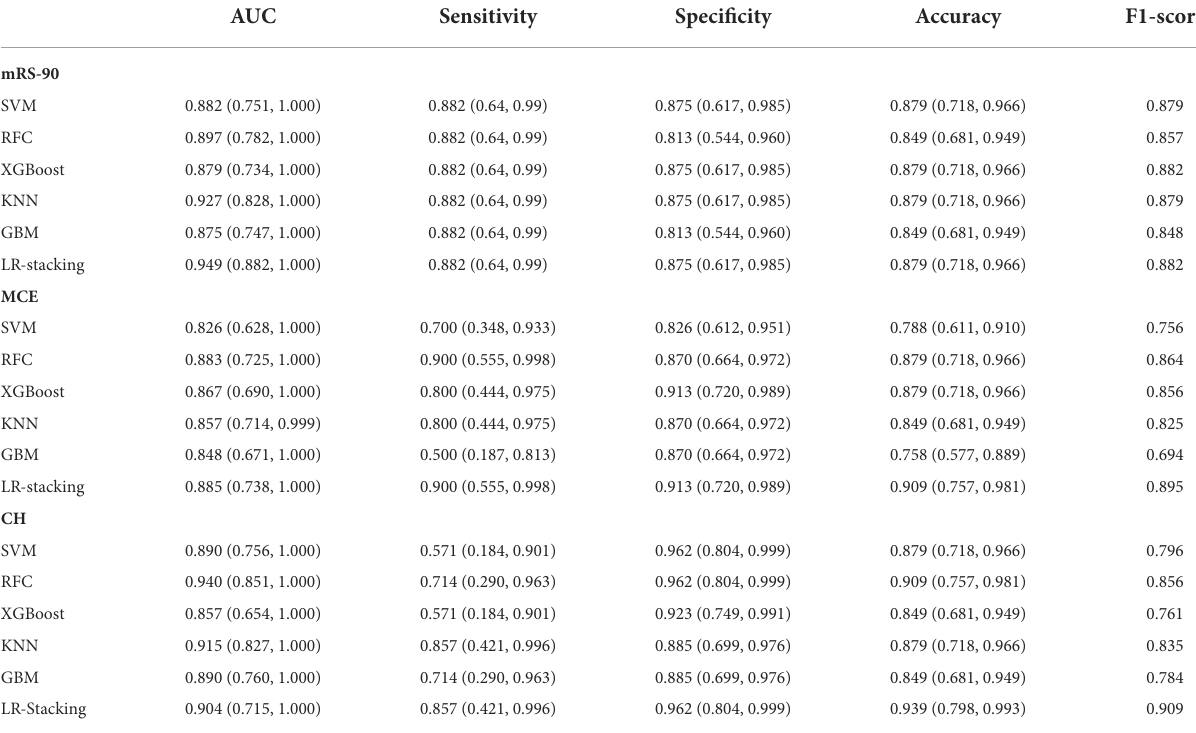
TABLE 2 The AUC, sensitivity, specificity, accuracy, and F1-score comparisons. AUC Sensitivity Specificity Accuracy